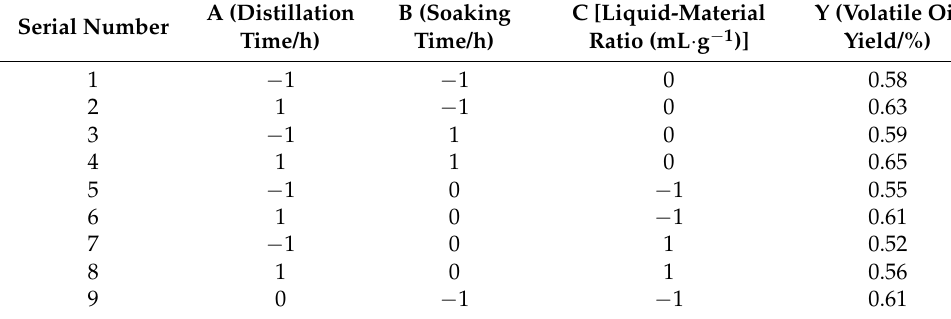
Table 2. The Box–Behnken designed experiments and